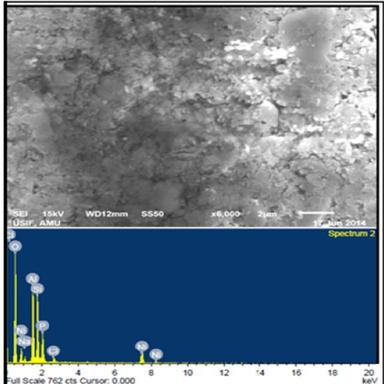
SEM supported EDX image of PVC–NP composite membrane.